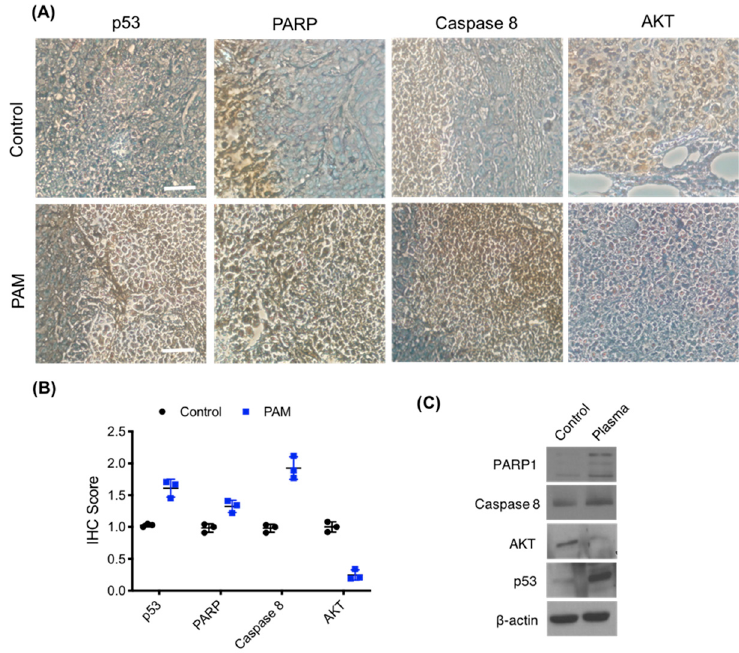
Figure 5. Antitumor effect of PAM in mice model. ( A ) Representative hematoxylin and eosin (H & E) staining of tissue sections of both groups (magnification, × 40). Immunohistochemical analysis of p53 , Parp , Casp-8, and Akt expression levels in control and PAM treated tumors tissues. Three independent slides were checked in each case. Scale bar = 100 µ m. ( B ) Graphical representation of IHC score of both groups. ( C ) Western blot analysis for p53 , Parp , Casp 8 , and Akt . ß-Actin is used for normalization.